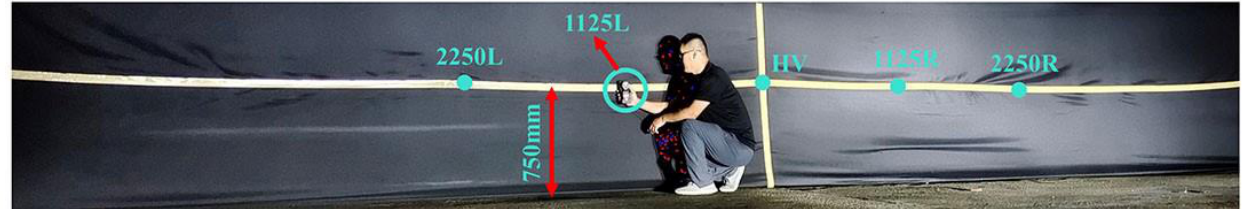
Figure 5. Field test diagram of the high-beam headlight.